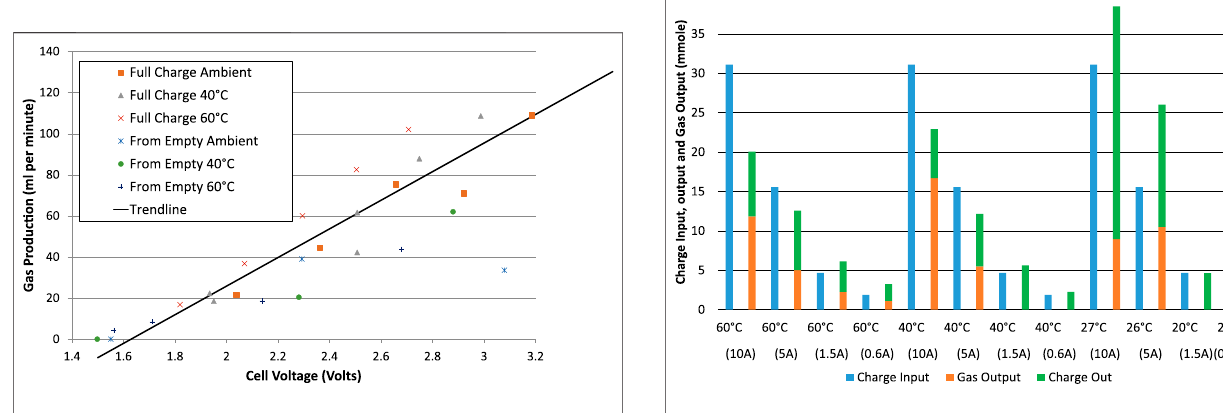
FIGURE 10 | Electrolysis tests starting with an almost-empty cell. Charge input, charge output and equivalent gas output in terms of effective charge used and at different charge and discharge